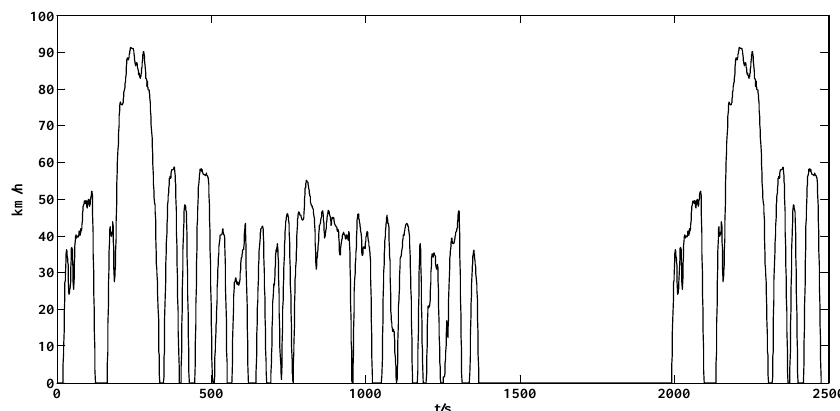
Figure 7. Driving cycle of Federal Test Procedure (FTP75).